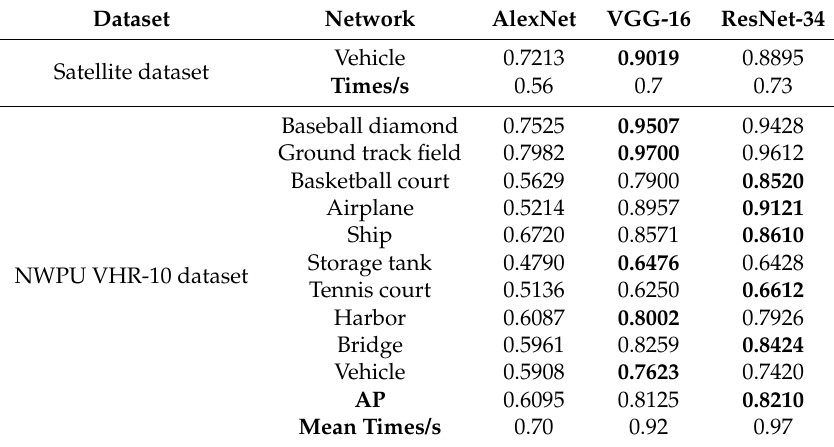
Table 8. Precision comparisons of the proposed MsRi-CCF using three different network architectures as the feature extractor. The best results are shown in